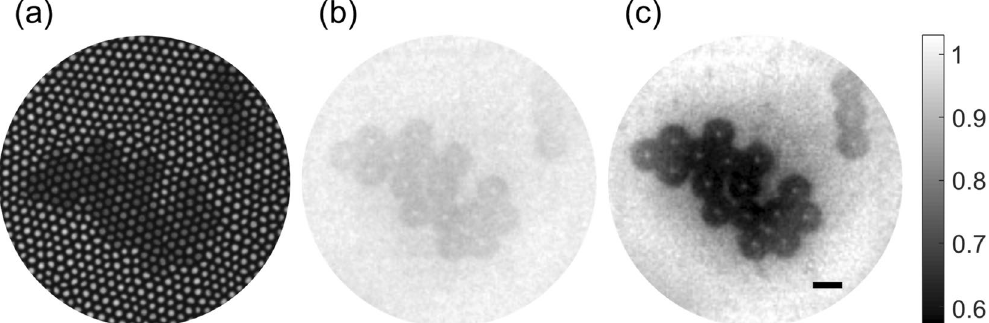
Figure 4. Imaging polystyrene beads in air. ( a ) Conventional reflection imaging with LED illumination, ( b ) with WIWD method, ( c ) with SIWD method. Scale bar: 10 μ m. For both ( b ) and ( c ), the background intensity was normalized and the color scales are the same. Color bar: normalized intensity.